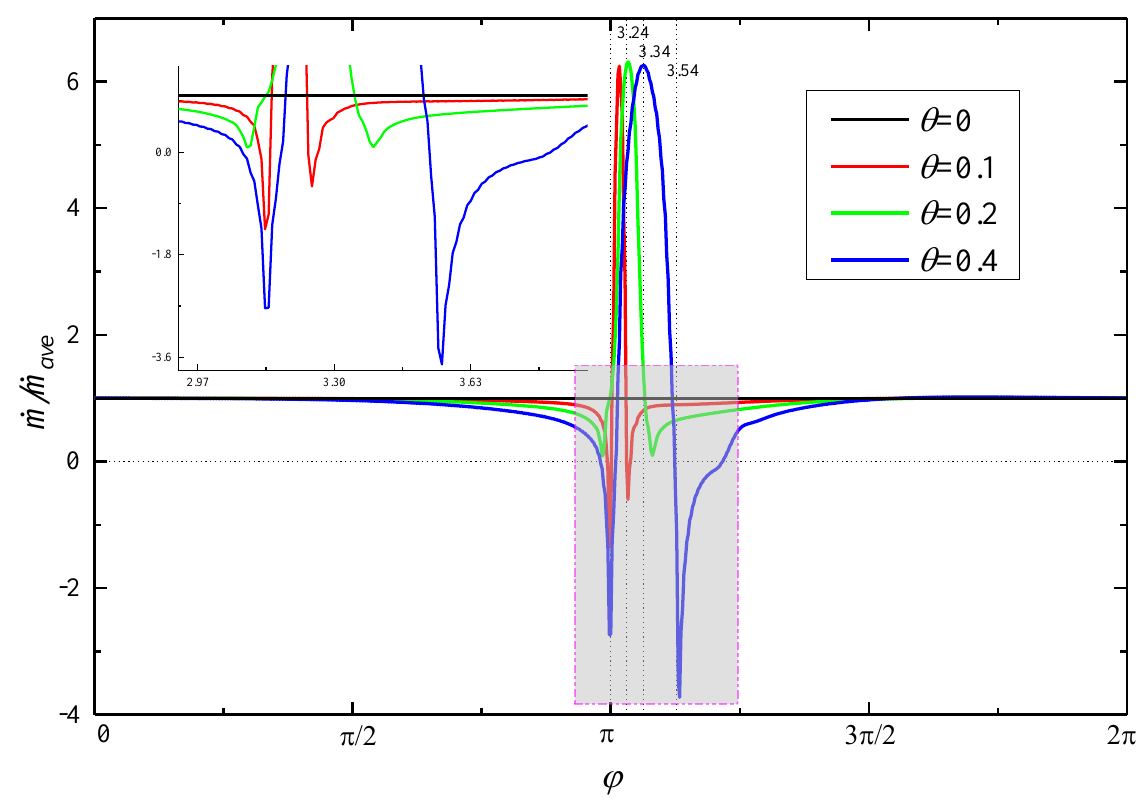
Figure 16. Distribution of mass flow rate for C w = 10,137, Re ϕ = 5.12 × 10 5 , E = 0.2 at r / b = 1.